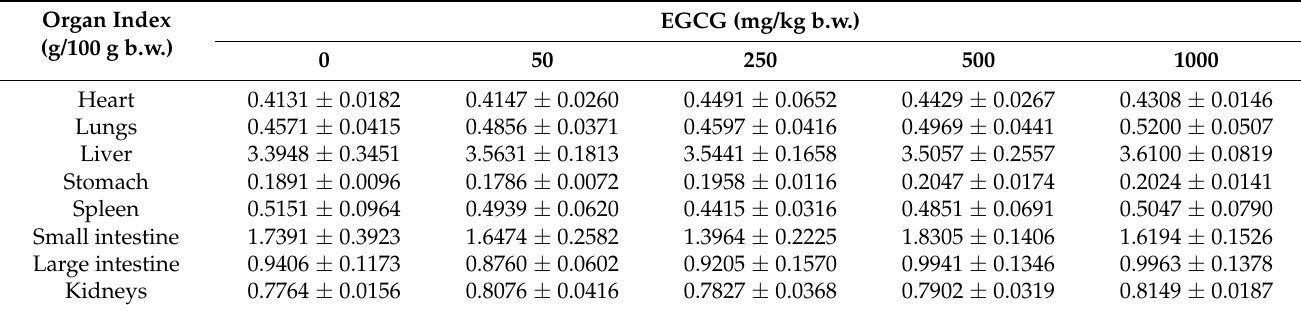
Table 5. Relative organ